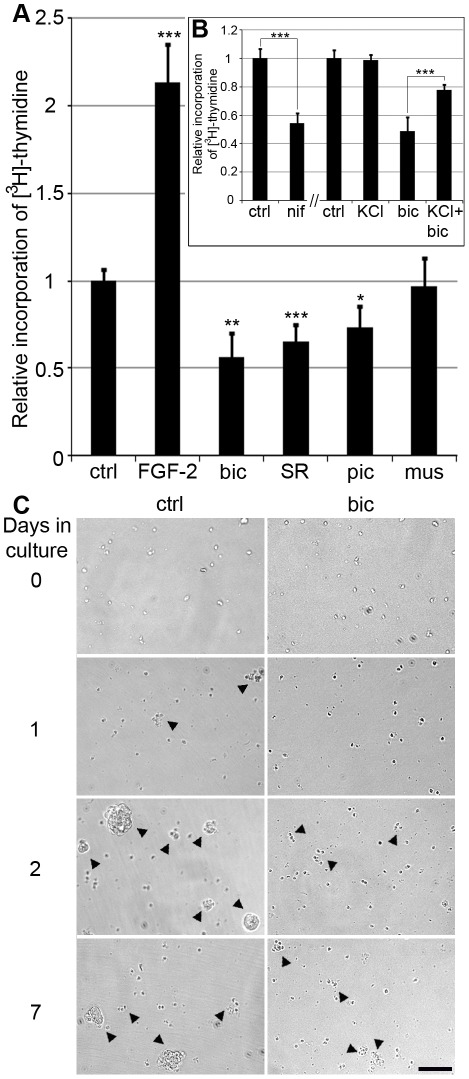
Effects of GABAA receptor and voltage-gated Ca2+ channel inhibitors on NPE cell proliferation.Bar graphs show the relative proliferation levels of dissociated NPE cells determined by incorporation of [3H]-thymidine. (A) Proliferation levels of cells treated with FGF-2 (1.5 µg/ml), bicuculline (20 µM bicuculline, 1 µM GABA), SR-95331 (50 µM SR-95531, 1 µM GABA), picrotoxin (50 µM picrotoxin, 1 µM GABA) and muscimol (50 µM muscimol, 1 µM GABA) in relation to control cells (1 µM GABA), (B) Proliferation levels of cells treated with the VGCC antagonist nifedipine (10 µM nifedipine, 1 µM GABA), KCl (20 mM, 1 µM GABA), bicuculline (20 µM, 1 µM GABA) or KCl + bicuculline (20 µM bicuculline, 20 mM KCl, 1 µM GABA) in relation to control cells (1 µM GABA). Vehicle and control for nifedipine treatment was DMSO (0.01%). Error bars ±SD, n = 4 independent cultures. Statistical test was one-way ANOVA, Tukey's multi-comparison post-hoc test; p<0.05*, p<0.01**, p<0.001***. (C) Bright-field phase contrast micrographs of cultured dissociated control and bicuculline-treated NPE cells. Arrowheads point at initial clusters and spheres with proliferating cells. bic, bicuculline; ctrl, control; FGF-2, basic fibroblast growth factor; mus, muscimol; nif, nifedipine; pic, picrotoxin; SR, SR-95531. Scale bar in (C) is 100 µm.